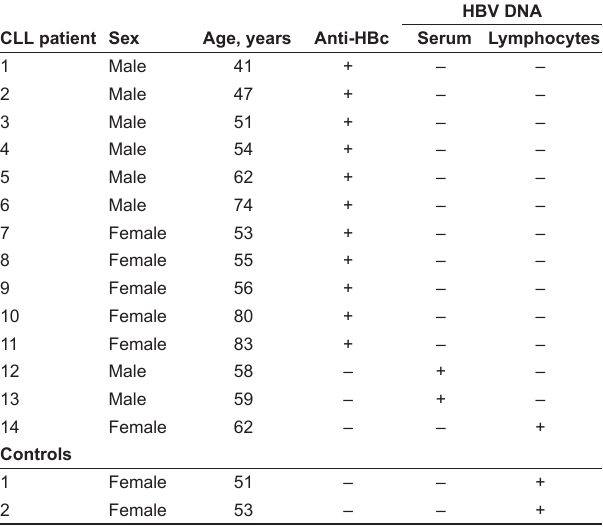
Table 1 Clinical and laboratory features of the study patients Feature